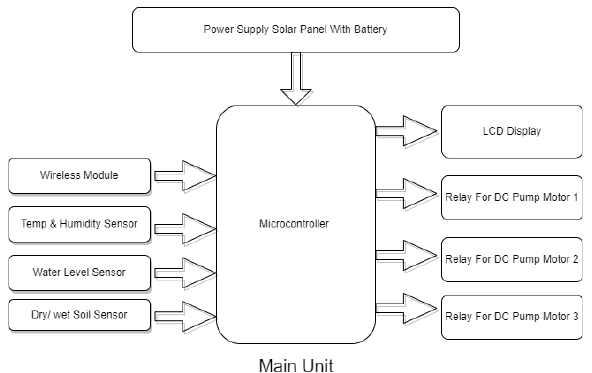
The design is split into two parts: the main unit and the remote